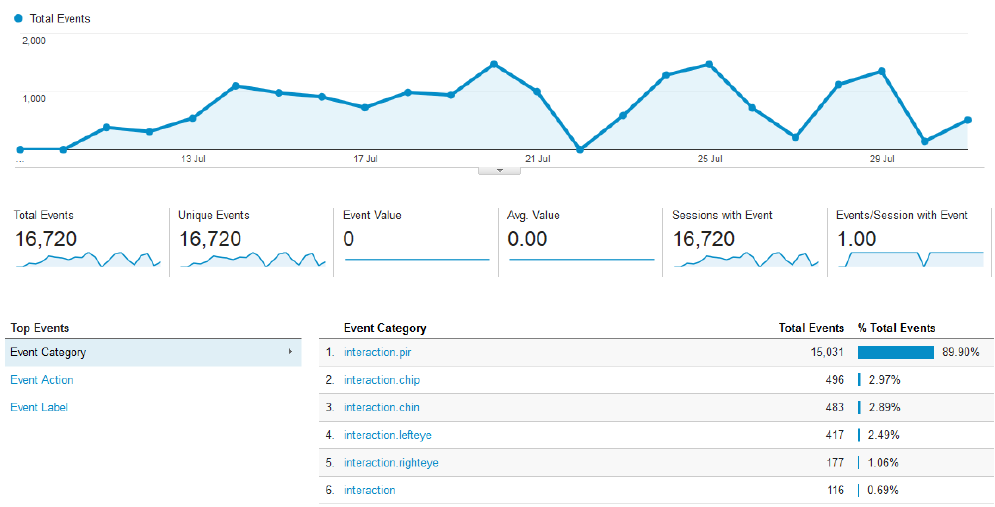
Figure 8. Daily counts of interactions with Erica during the Go! Rhinos deployment, recorded using Google